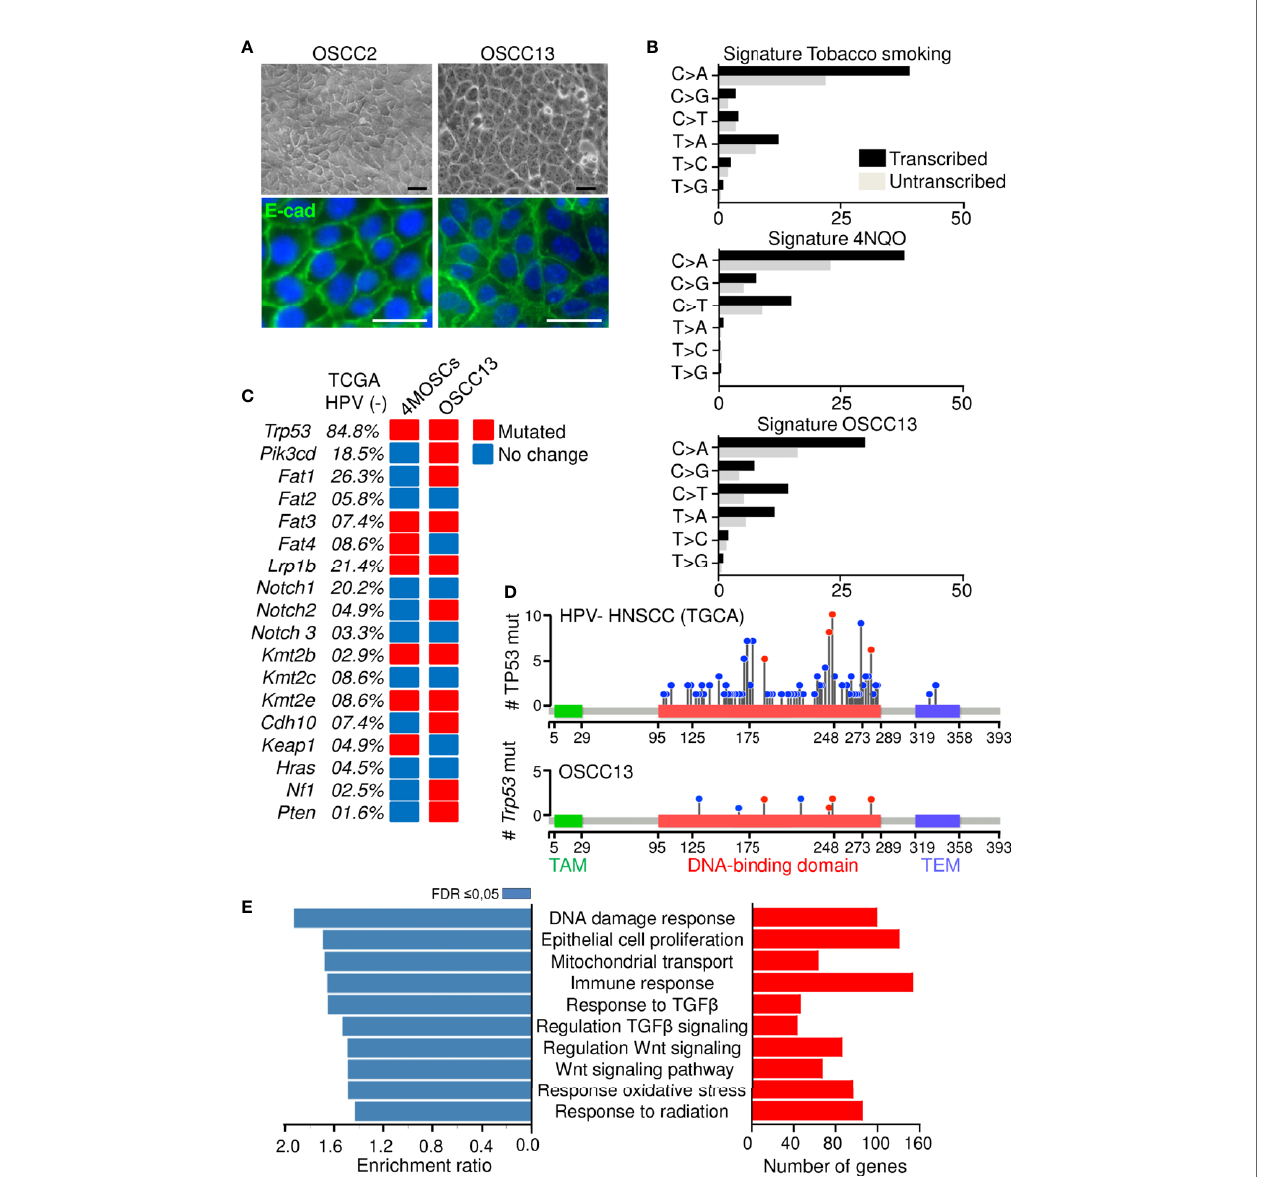
FIGURE 1 | Phenotype of a new OSCC model. (A) Phase contrast and IF imaging of E-cadherin in OSCC2 and OSCC13 cells. Scale bar, 25 µm. (B) Percentage of somatic substitutions located in the translated or untranslated genome regions in patients with smoking-associated HNSCC (top (32), in 4NQO-derived lesions (middle (24); and in OSCC13 cells (bottom). (C) Graphical matrix representation of individual mutations in OSCC13 compared to 4MOSCs and smoking-associated HNSCC (24, 32). The most frequently observed alterations in the indicated genes of human HPV negative HNSCC (TGCA database) and the corresponding percentage of mutations in 4MOSCs and OSCC13 are shown. The presence (red) or absence (blue) of mutations are indicated for OSCC13 and the 4MOSC1 – 4 cells when at least two of the four cells showed the same phenotype. (D, E) RNA data analysis of cultured OSCC13 cells 24 h after plating. (D) Lollipop mutational plot of TP53 mutations in human HNSCC (HPV-negative) tumor samples from TCGA database (top) and mouse HNSCC cell line (OSCC13) (bottom). The frequency of mutations is represented by the height of the lollipop. The blue circles indicate mutations speci fi c to human or mouse, and the red circles illustrate mutations common to human and mouse HNSCCs. TAM, Transactivation motif; TEM, Tetramerisation motif. (E) Over-represented gene ontology terms as determined by the Webgestalt program and Geneontology database. Bar charts show the enrichment ratio (blue) and expressed gene numbers (red) of the 10 most over-represented GO processes associated with FDR ≤